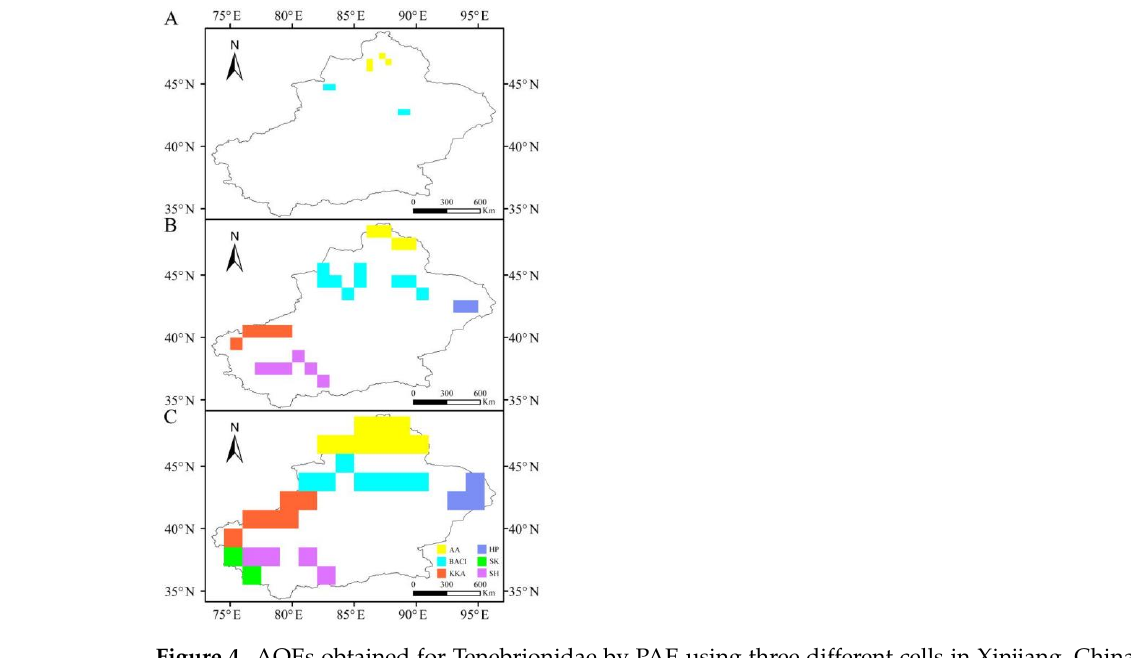
Figure 4. AOEs obtained for Tenebrionidae by PAE using three different cells in Xinjiang, China: ( A ) 0.5° grid size, ( B ) 1° grid size, and ( C ) 1.5° grid size.